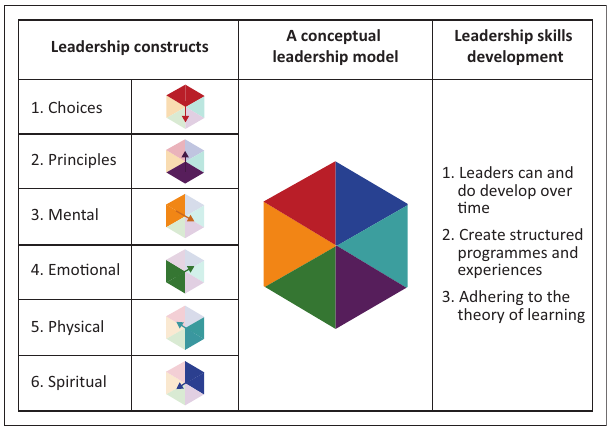
FIGURE 1 : A conceptual model for leadership skills